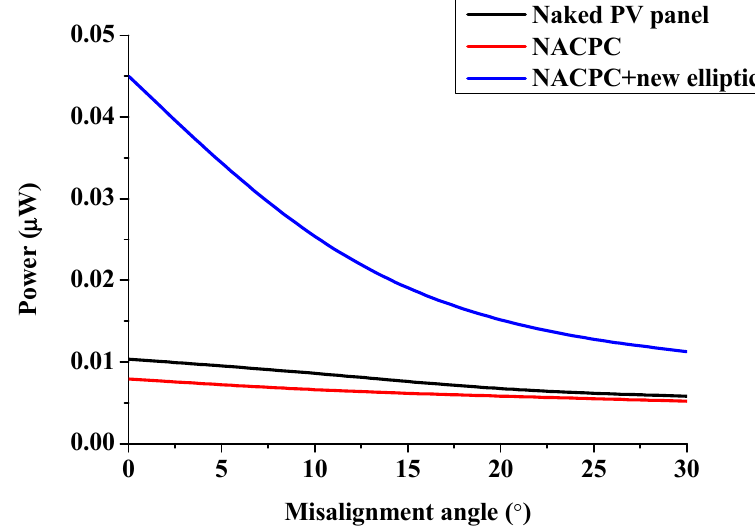
Figure 30. The experimental results of the 2D prototype of the NACPC with the new elliptical collimator.